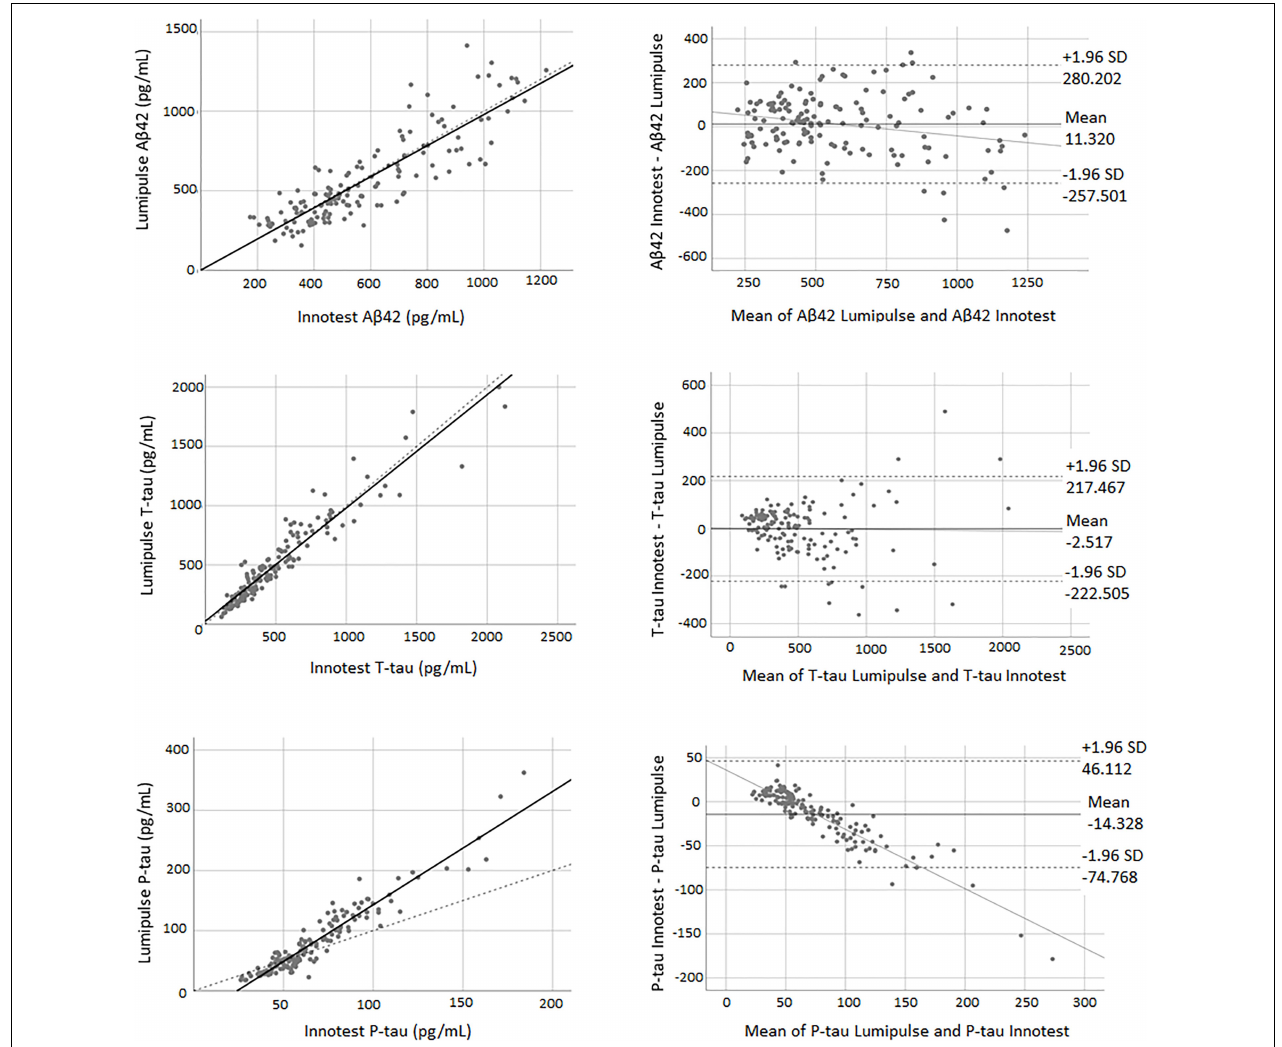
FIGURE 1 | The correlation and Bland-Altman plots for A β 42, T-tau, and P-tau measurements obtained by Lumipulse and Innotest ELISA methods ( n = 149). Each point is defined as the measurements of Lumipulse and ELISA assays on the same biological sample. In correlation plots, the solid lines represent the estimated regression line, and the dotted line represents the identity line ( x = y ). In the Bland-Altman plots, solid lines represent the slope observed.